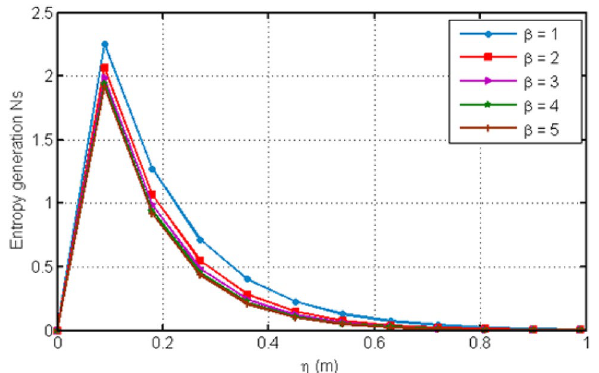
Figure 8. Variation in entropy generation for diverse values of C 6 H 9 NaO 7 parameter β .